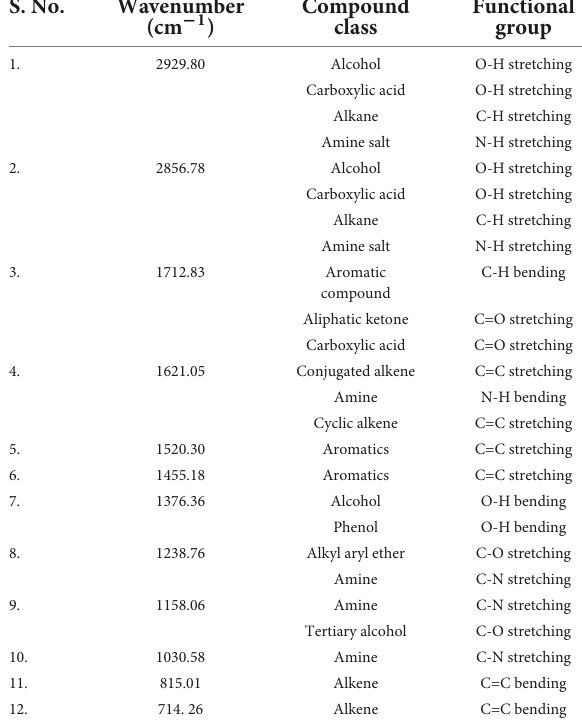
TABLE 2 Fourier transform infrared spectrometer (FTIR) peaks and their assigned functional groups of ethyl acetate root extract of Skimmia anquetilia